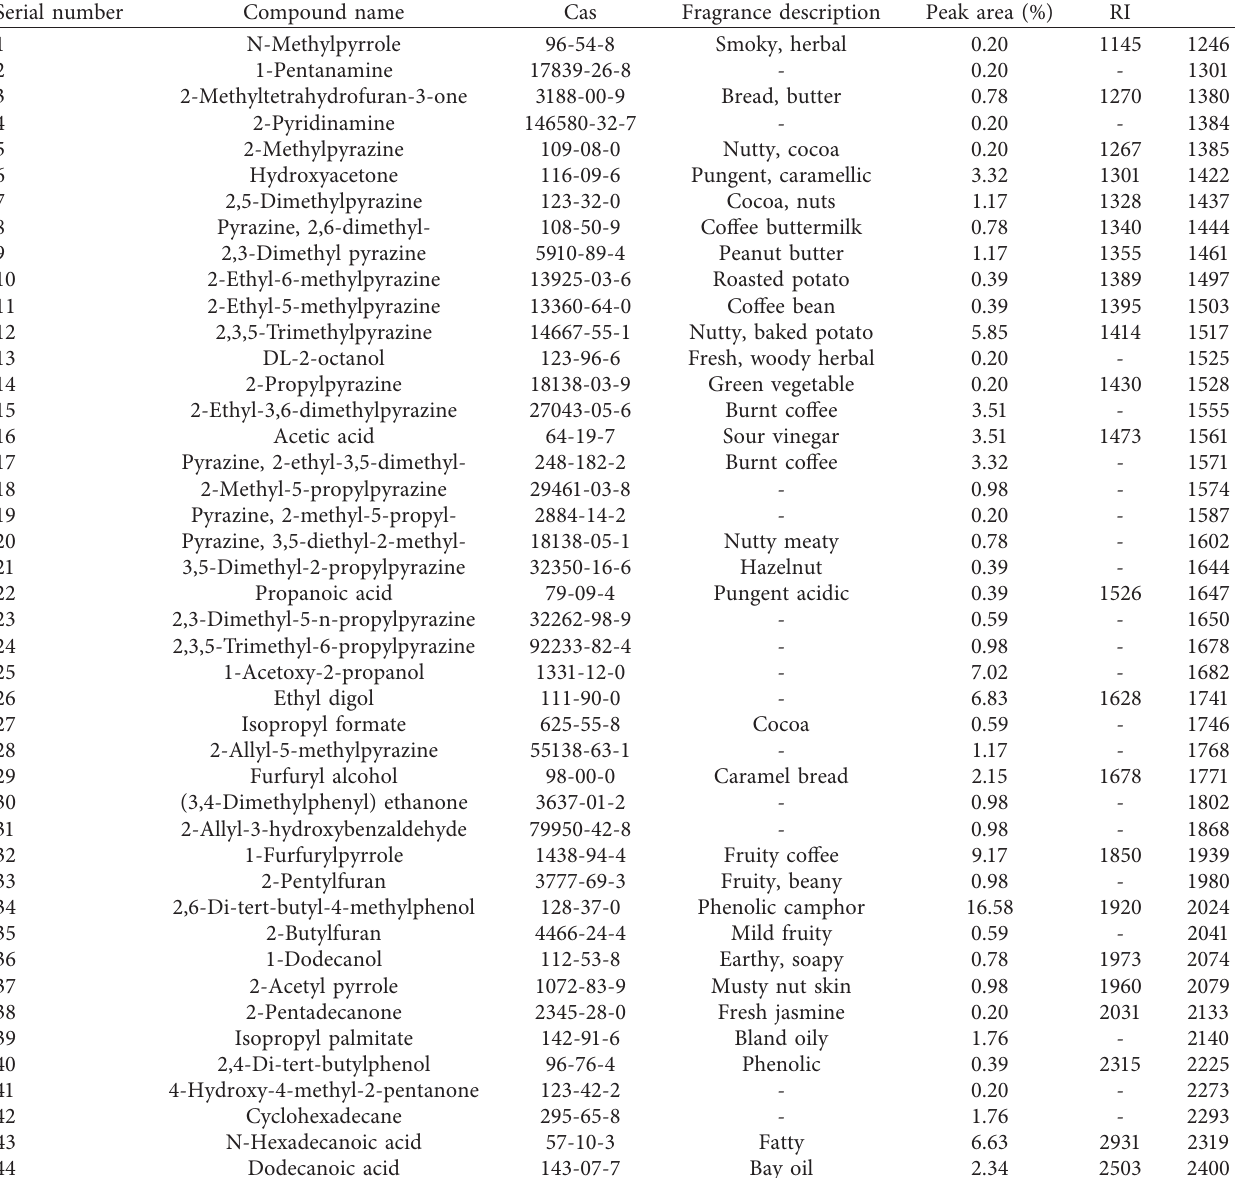
Table 4: Volatile compounds identified in MRPs using